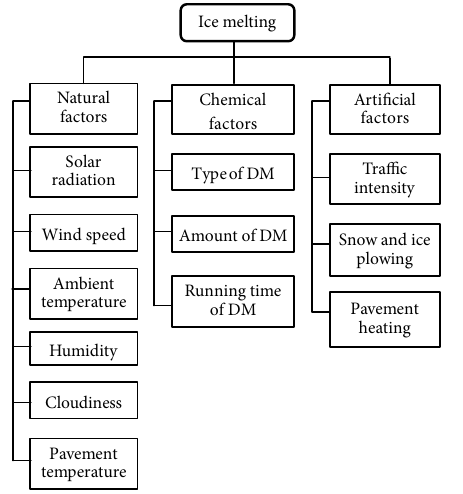
Fig. 2. Ice melting process when a DM is applied: a – ice melting zones; b – change of ice surface